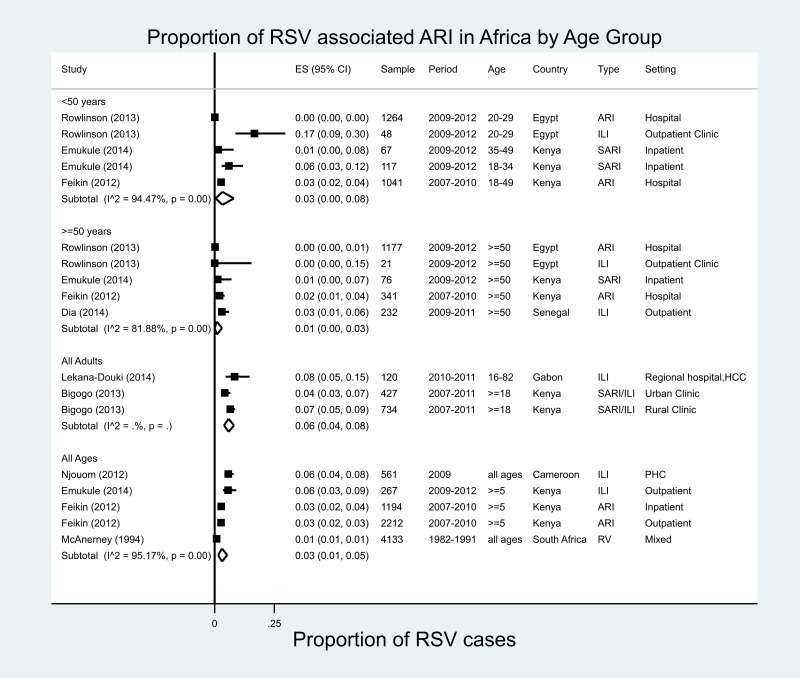
Proportion of RSV-associated ARI/ILI in the Africa region.